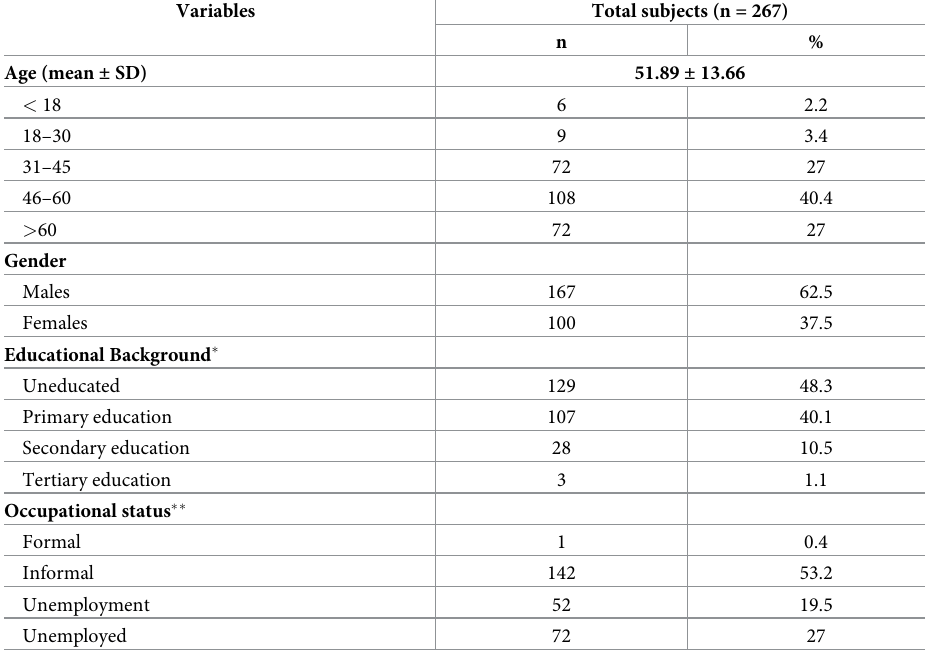
Table 1. Demographic characteristics of study